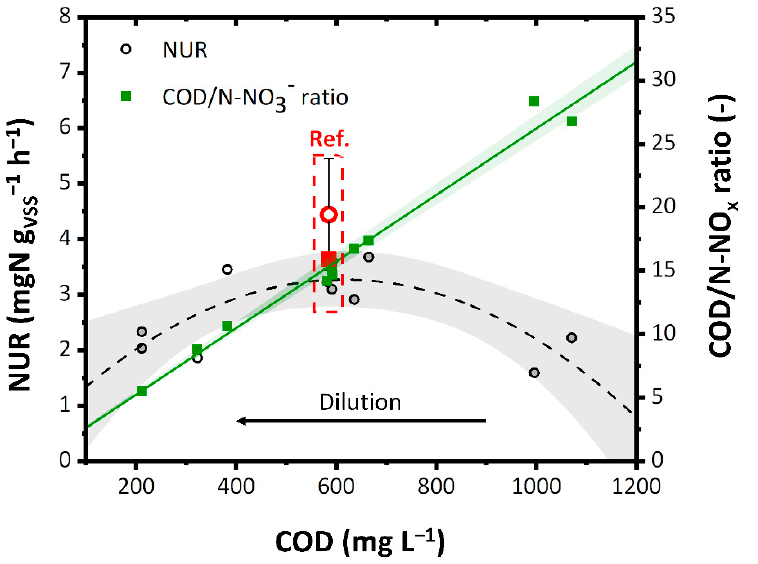
Figure 6. NUR as a function of COD and COD/N-NO x ratio. Ref: Reference value. The colored bands represent the 95% confidence interval of the linear fitting.